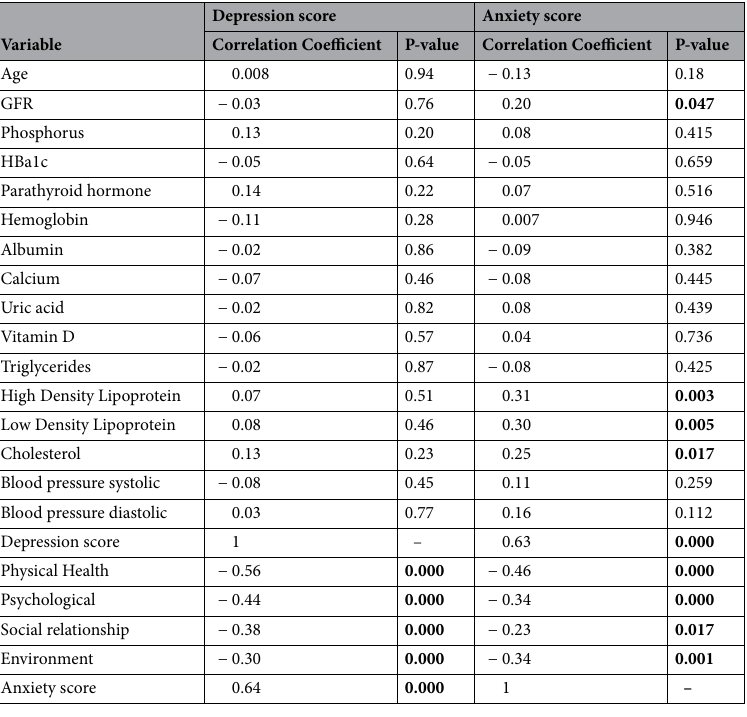
Table 4. Depression and Anxiety scores correlation. Significant values are in bold.